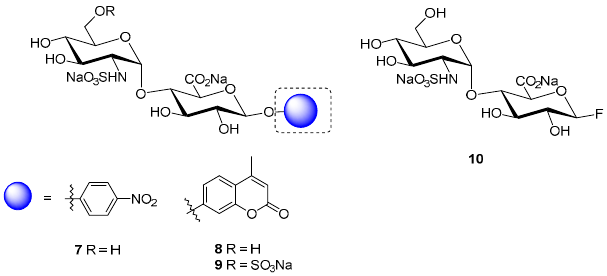
Figure 4. Structures of synthetic disaccharide substrates for heparanase [62,64].